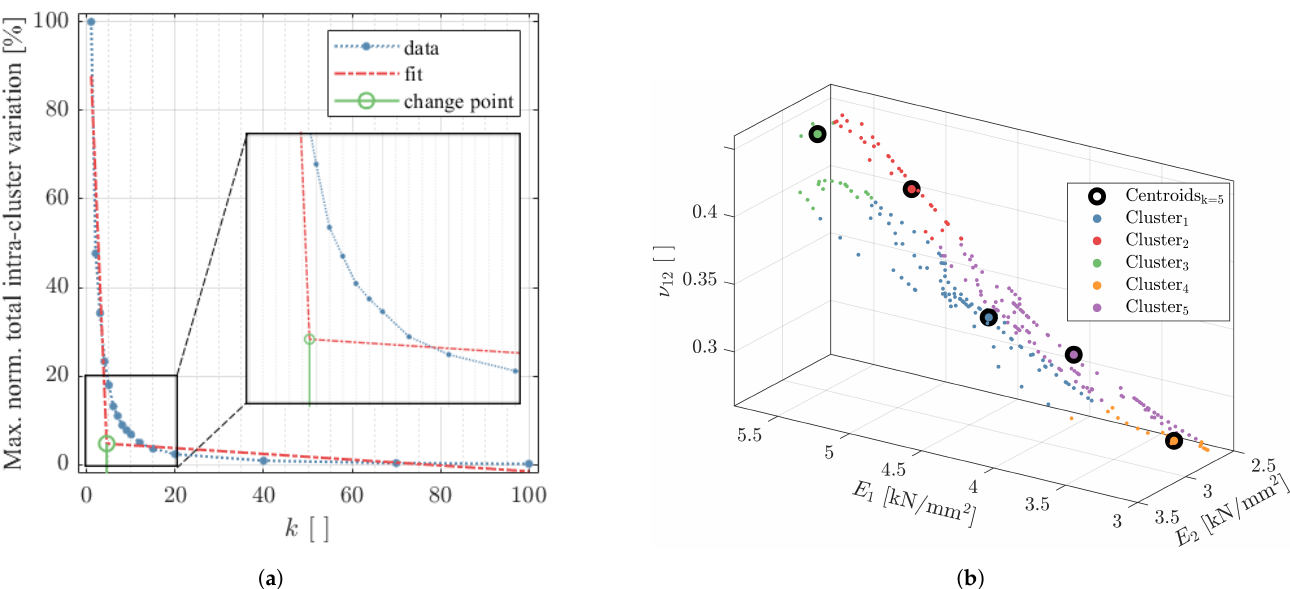
Figure 10. ( a ) Elbow plot with optimal number of clusters indicated in green and ( b ) visualization of material properties partitioned into five clusters with corresponding centroids for part XZ P